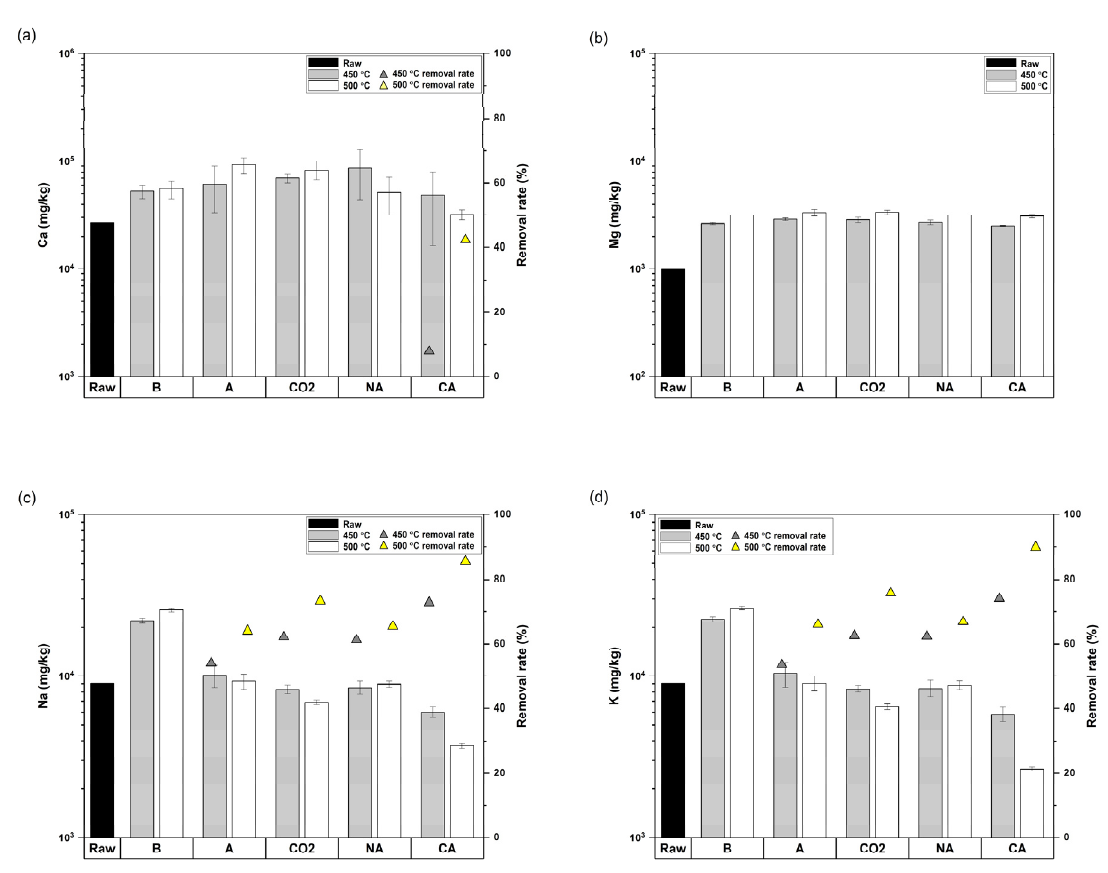
Figure 2. Alkali and alkaline earth metal (AAEM) contents (mg/kg) and removal rate (%) of raw biochar samples and those after pyrolysis at 400 °C and 500 °C; ( a ) Ca, ( b ) Mg, ( c ) Na, and ( d ) K. Error bars represent standard deviation (n = 2).